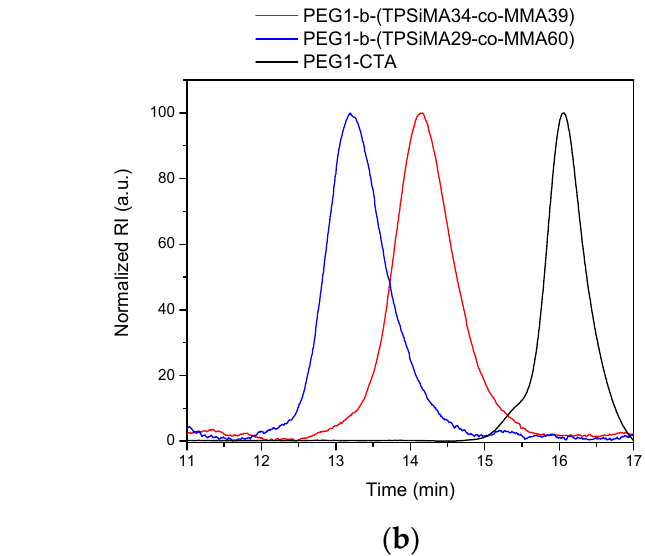
Figure 2. Normalized GPC curves of ( a ) PEGz-b-(TRSiMAx-co-MMAy) in CHCl3 and ( b ) the cor-responding PEG-based macromolecular RAFT chain transfer agents (PEGz-CTA).